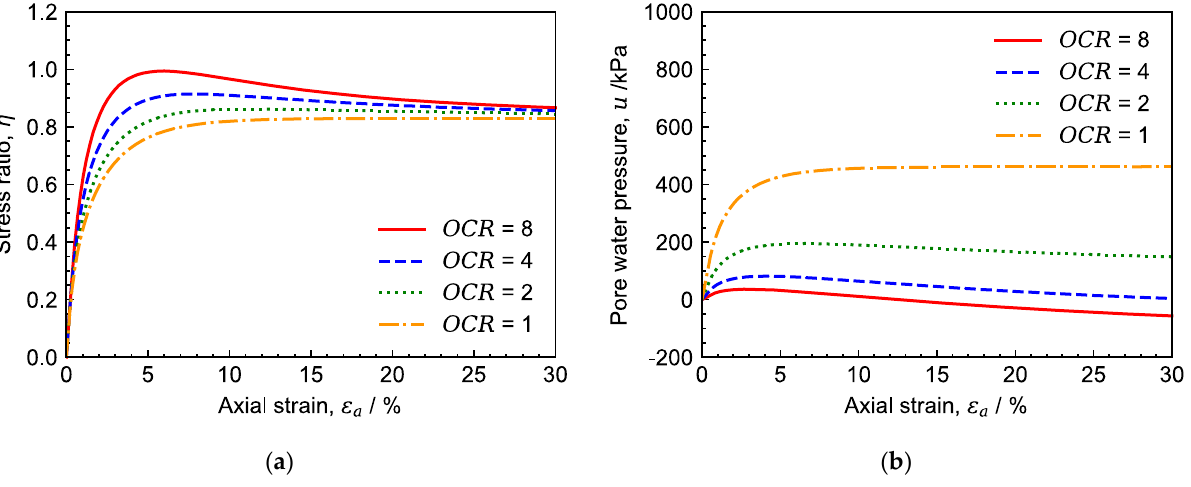
Figure 6. Effect of OCR on the behaviors of the over-consolidated clay during undrained shearing: ( a ) the stress ratio–axial strain relation; ( b ) the pore water pressure–axial strain relation.